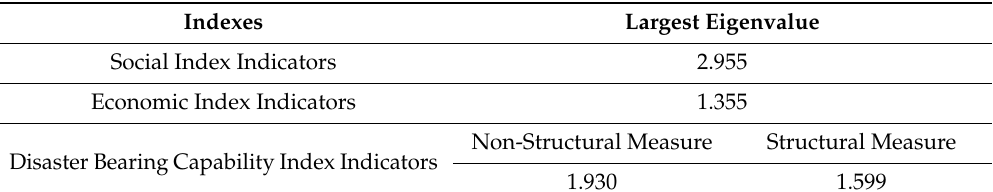
Table 2. The largest Eigenvalue of indexes considered for storm surge vulnerability.